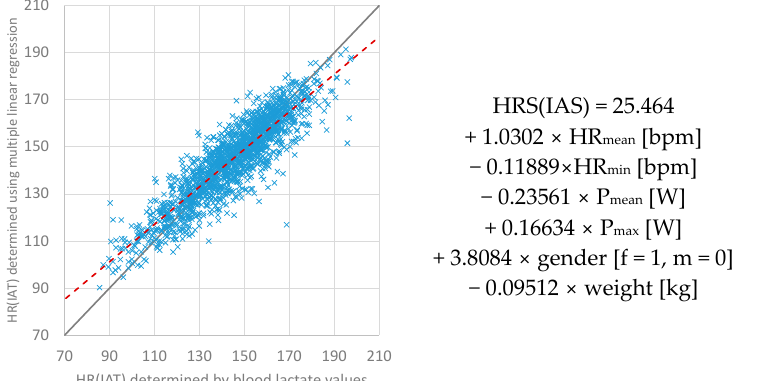
Figure 1. The comparison between HR(IAT) values on the horizontal axis determined by means of blood lactate values and the HR(IAT) values on the vertical axis determined by means of multiple linear regression. The proposed linear regression model for determining HR at IAT was compared to the Karvonen formula (Figure 2). The proposed method shows a lower RMSE (8.77 bpm) than the Karvonen formula (RMSE of 11.2 bpm), and HR determination at IAT is more exact using linear regression.